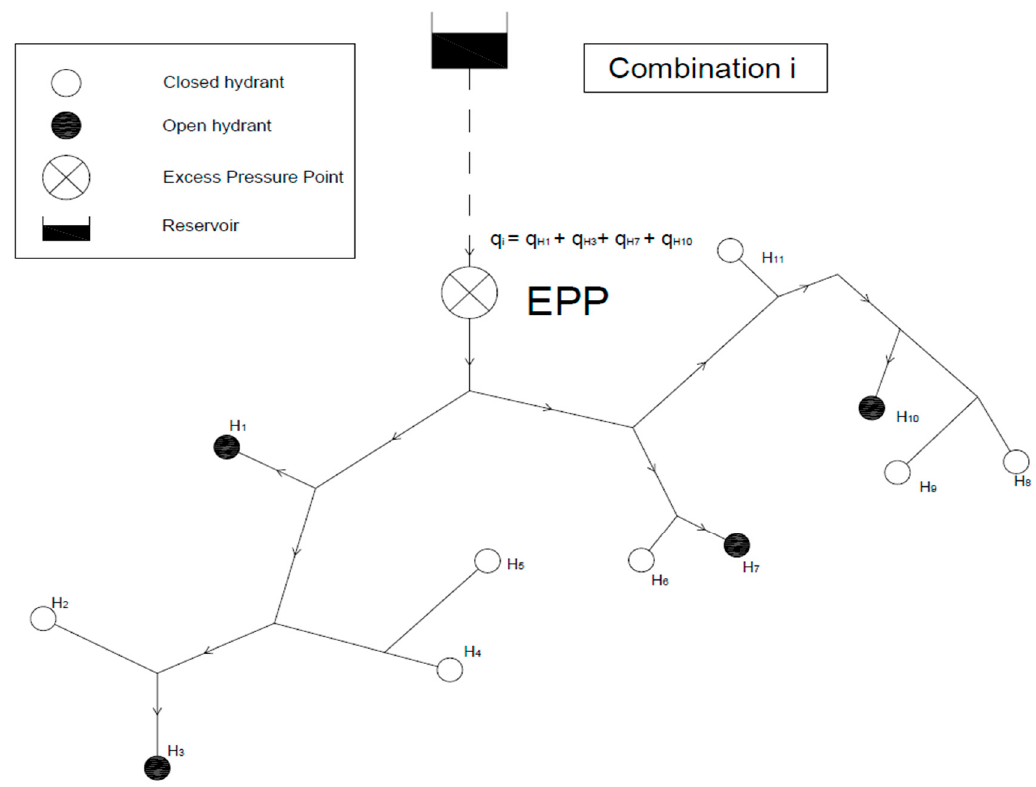
Figure 2. Random combination of downstream open hydrant for a general Figure 2 . Random combination of downstream open hydrant for a general EPP.